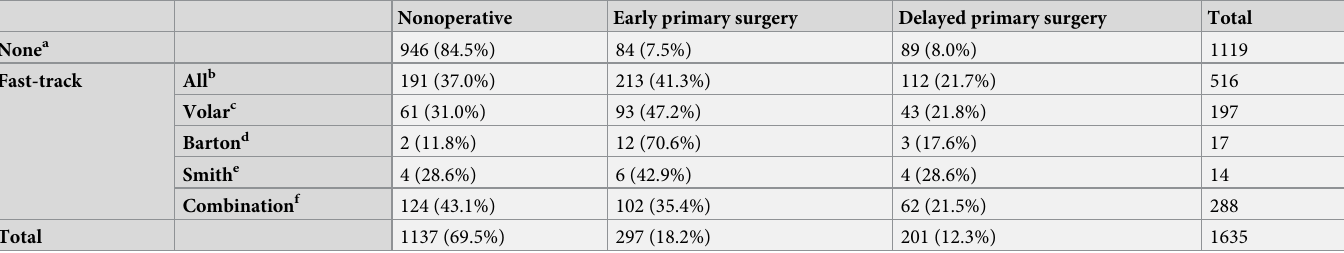
Table 4. Presentation of fracture treatment depending on fracture type in a retrospective cohort study of 1,635 DRFs in two hospitals in Sweden in